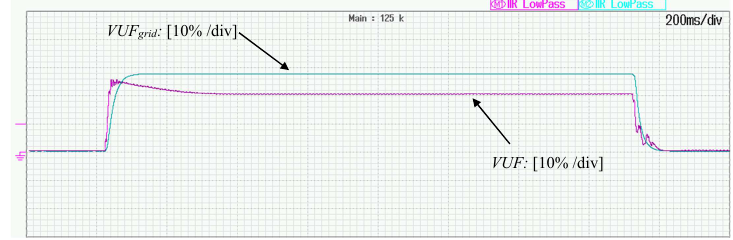
Figure 7. Operation under single-phase voltage drop ( V ga = 0.35p.u.): Voltage unbalance factors.